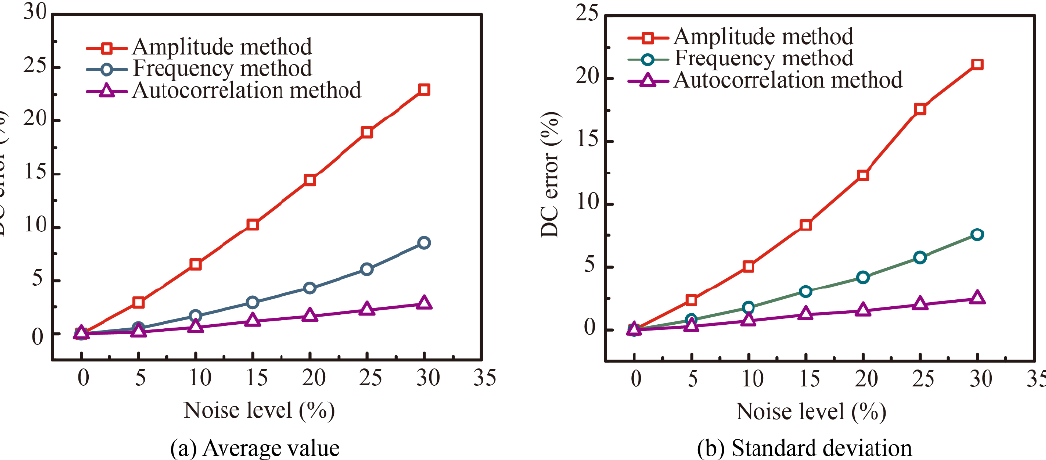
Figure 7. The errors of the retrieved DC proportions for the inversion of shear cracks calculated by the three methods.